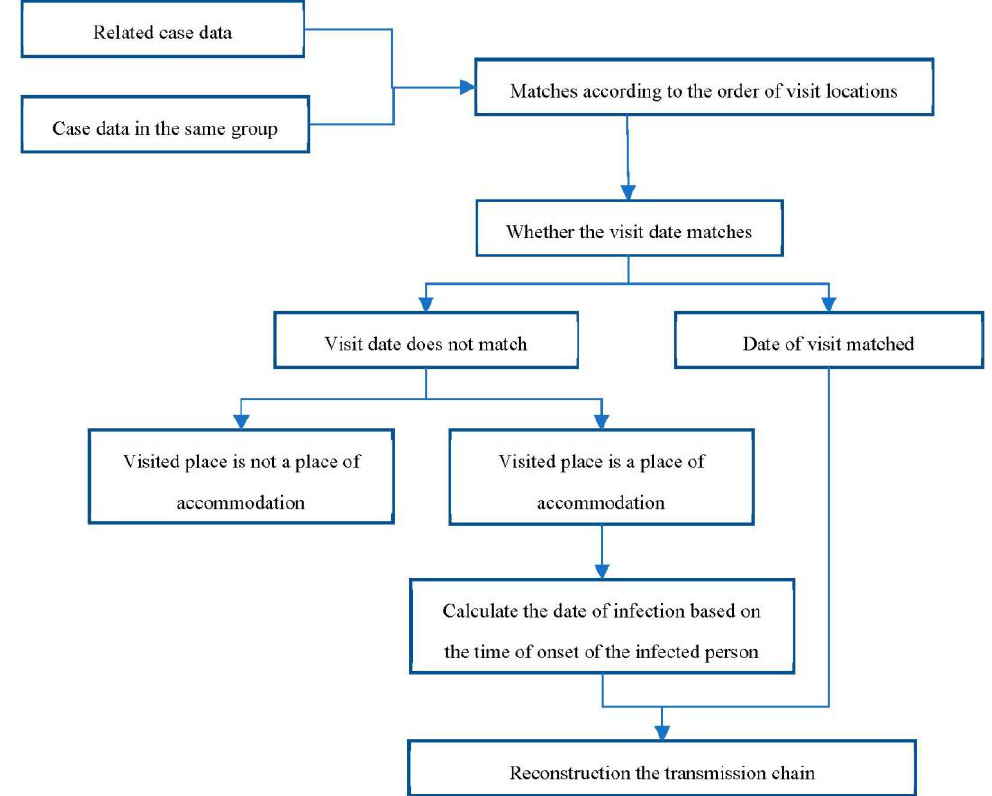
Figure 2. Flowchart of COVID-19 transmission chain